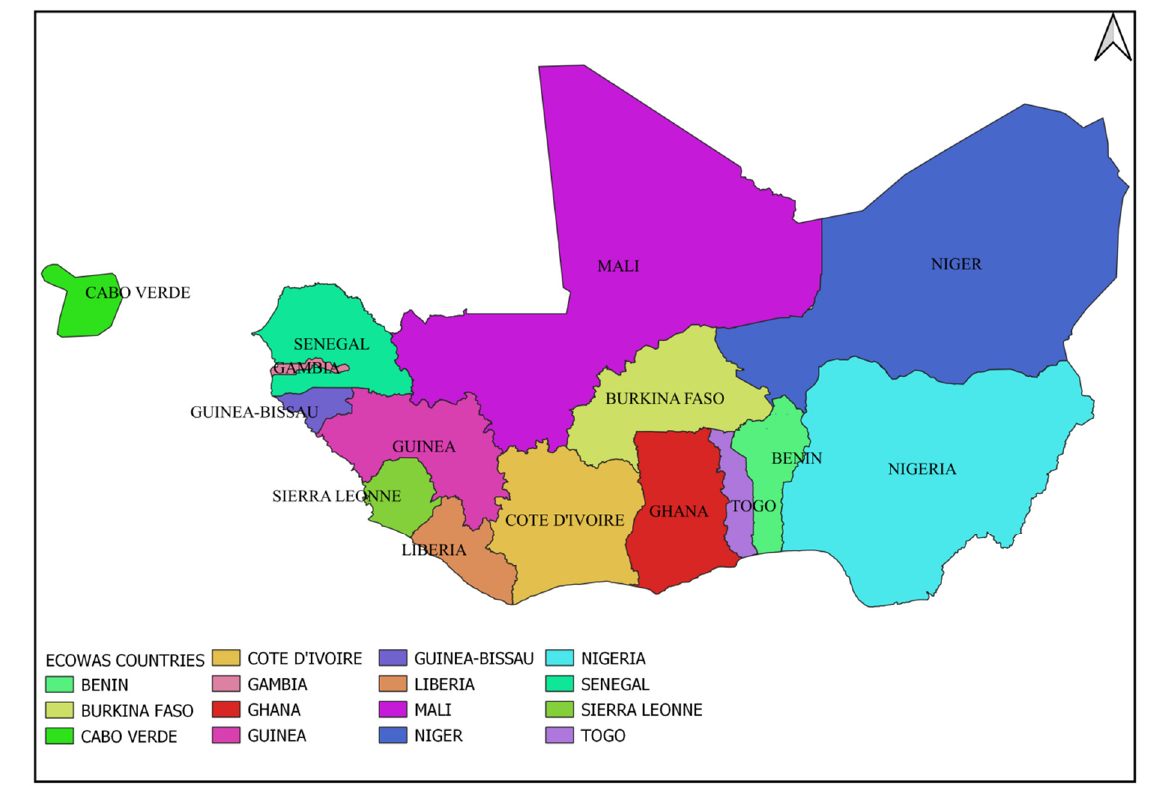
Figure 1. Countries in the ECOWAS region.